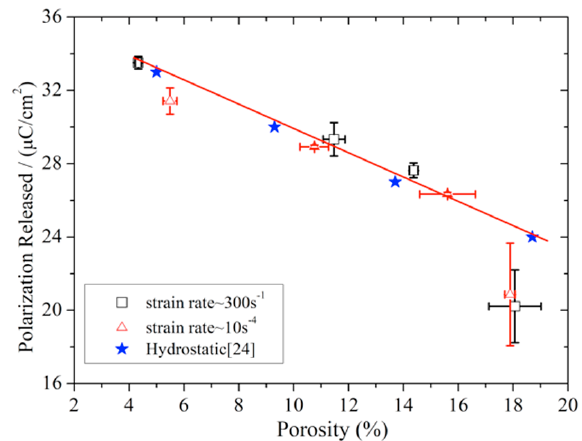
Figure 13. The peak of polarization released as a function of porosity for poled ceramics under different stress states.